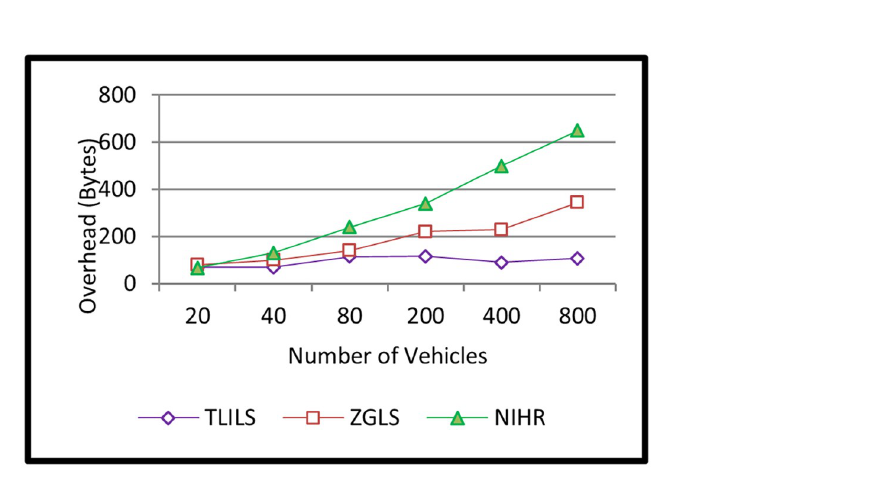
Fig 7. Information dissemination overhead of the TLILS, ZGLS, and